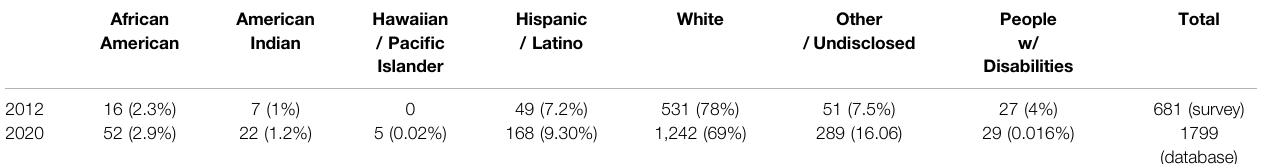
TABLE 5 | Demographics of the SDB membership (based on voluntary membership responses in 2012 and 2020) African